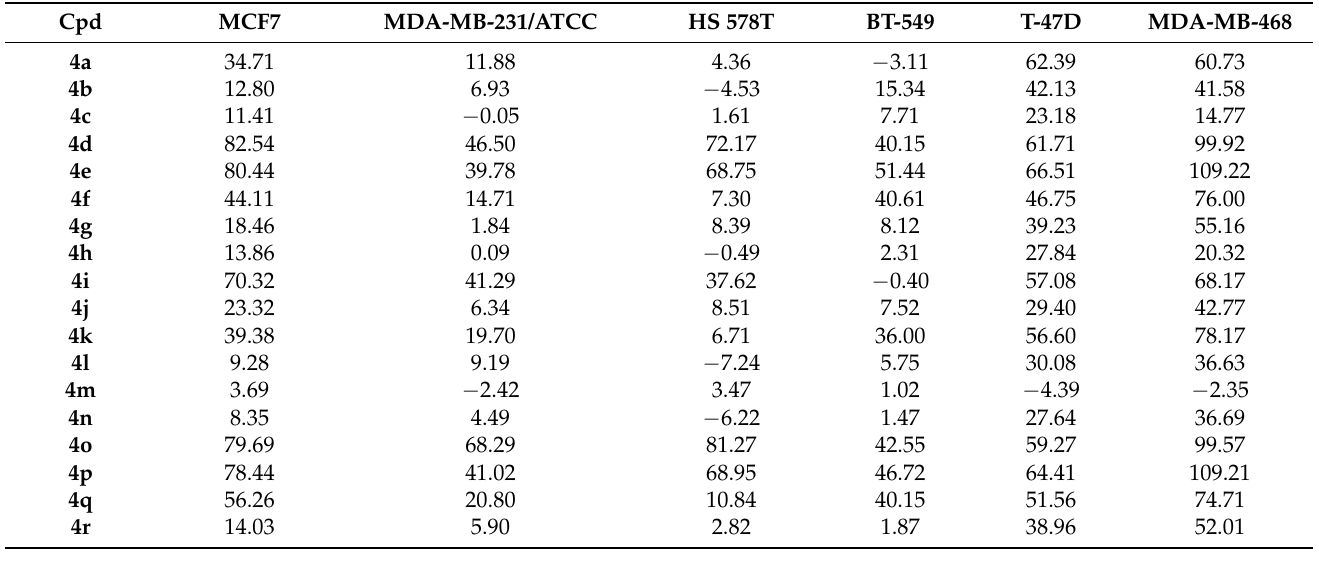
Table 13. Anti-proliferative activities (% growth inhibition) of the target compounds 4a ‒ r against breast cancer cell lines.